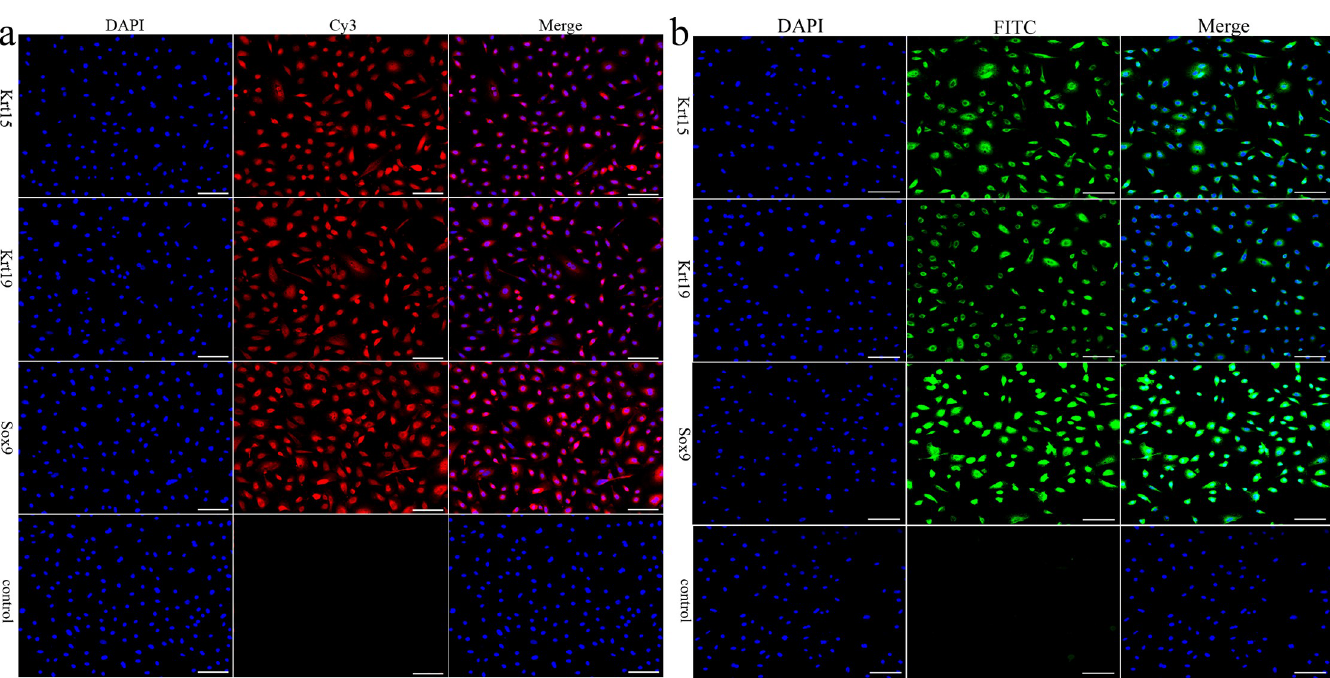
Fig 2. Identification of the in vitro cultured HFSCs. (a): Immunocytochemistry staining of Krt15, Krt19 and Sox9 in the anagen secondary HFSCs. (b): Immunocytochemistry staining of Krt15, Krt19 and Sox9 in the telogen phase secondary HFSCs. Scale bars 100 μ m. Control was HFSCs incubated with 10% goat serum instead of primary antibody; red, Cy3–conjugated goat anti-rabbit IgG; green, Fluorescein (FITC)–conjugated goat anti-rabbit IgG; blue, DAPI staining.